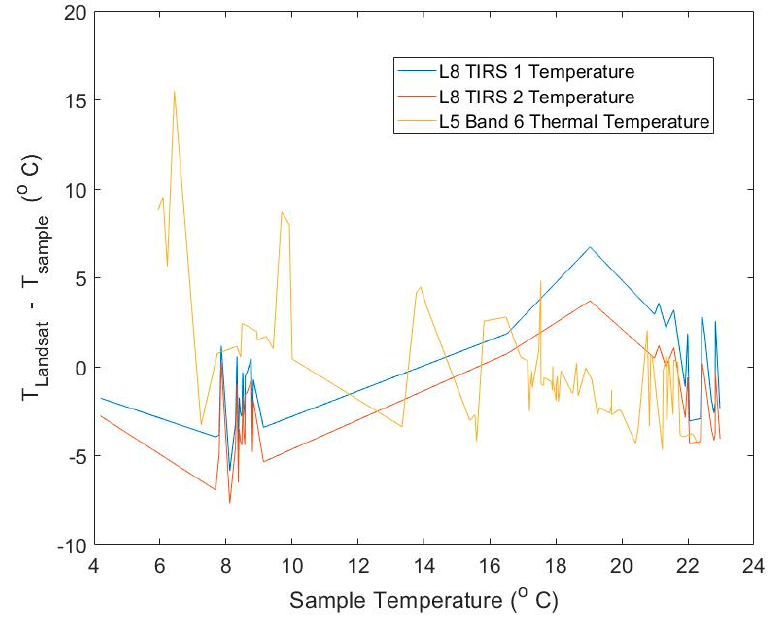
Figure 4. Satellite-based temperature calculation errors based on sampled temperature values.